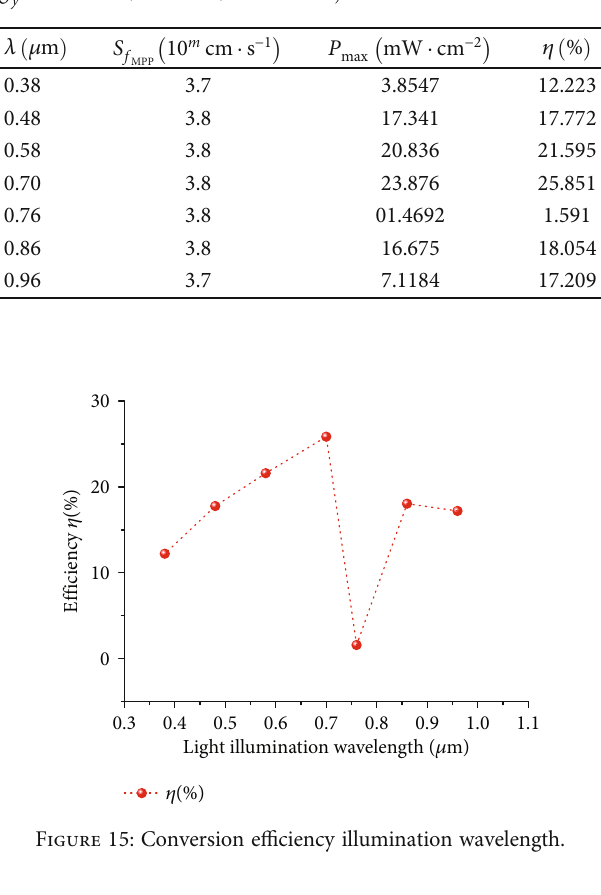
Table 2: Maximum power and conversion e ffi ciency for di ff erent solar illumination wavelengths ð L